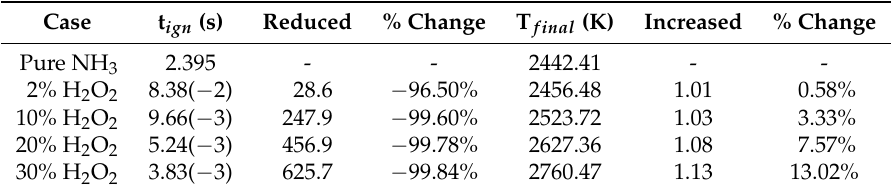
Table 3. Absolute and relative change of ignition delay times and final temperatures for all cases considered; numbers in parenthesis denote power of ten.